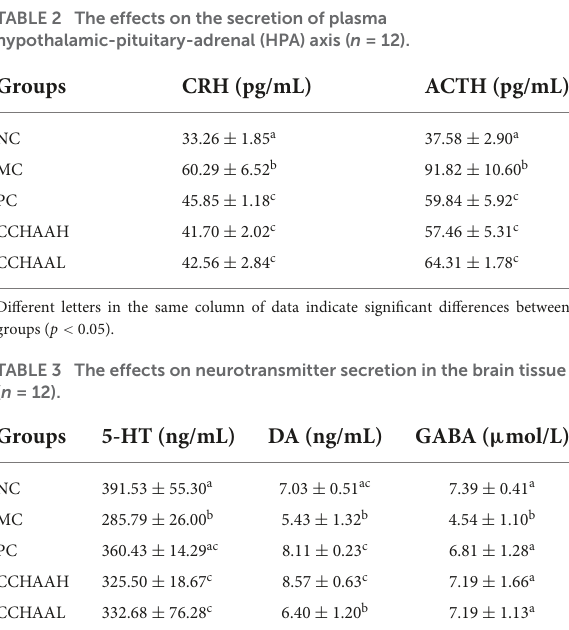
Different letters in the same column of data indicate significant differences between groups( p < 0.05).